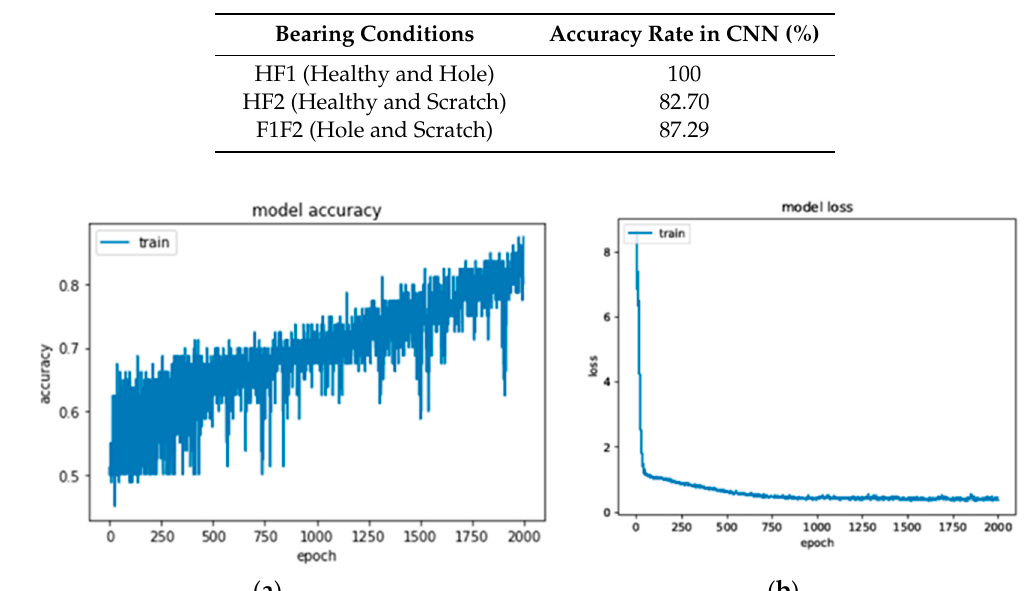
Figure 12. Diagnosis ( a ) accuracy result and ( b ) loss of the proposed system.